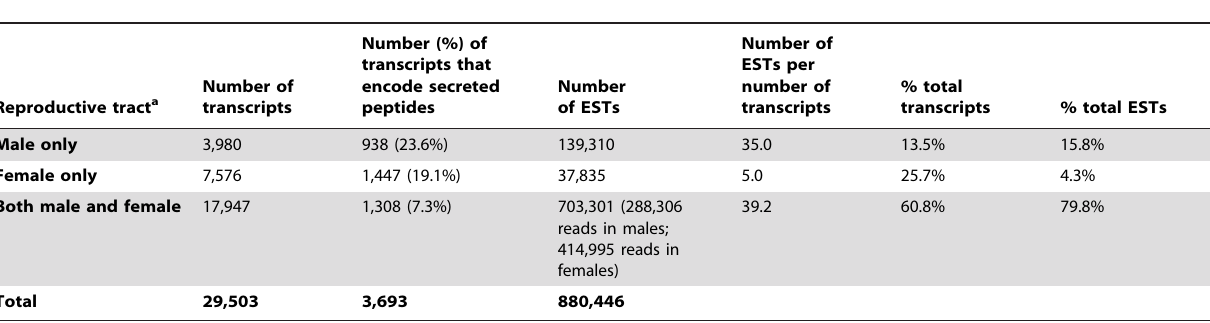
Table 1. Summary of transcriptome sequence datasets of Ae. albopictus reproductive tissues.